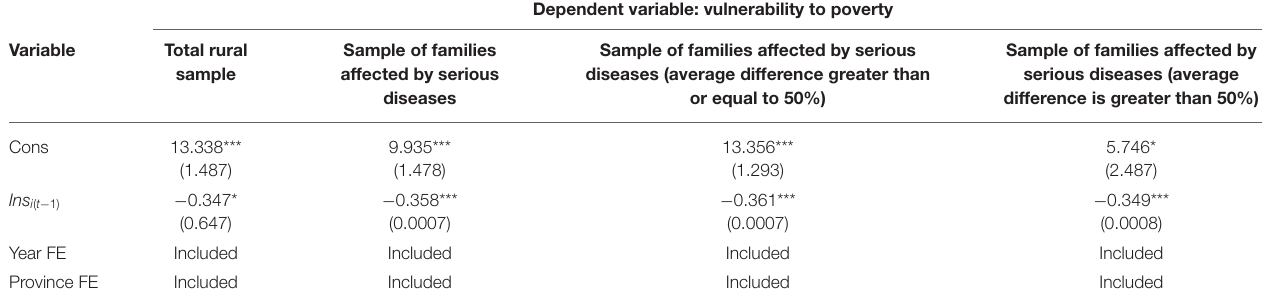
TABLE 7 | Major illness insurance and vulnerability to poverty Lag phase I.